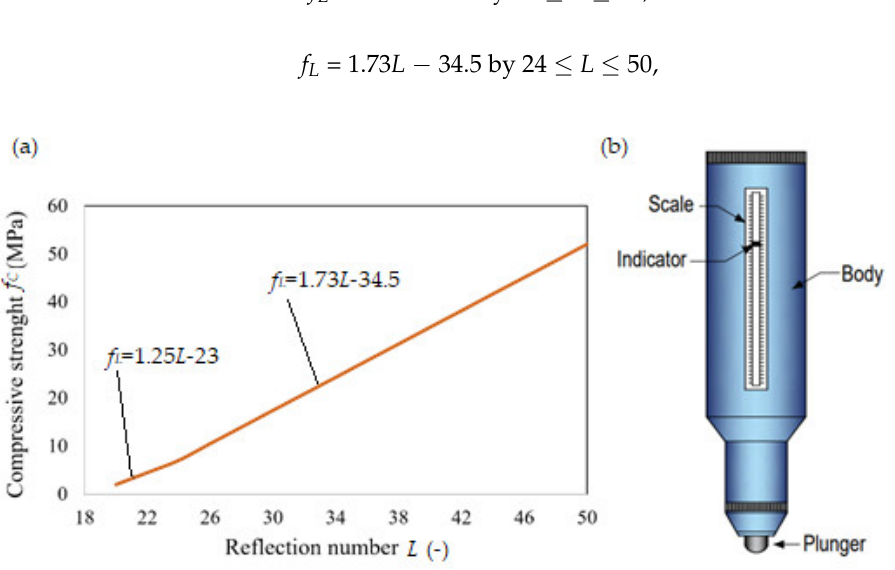
Figure 1. ( a ) Base curve according to the standard [13]; and ( b ) Schmidt hammer.